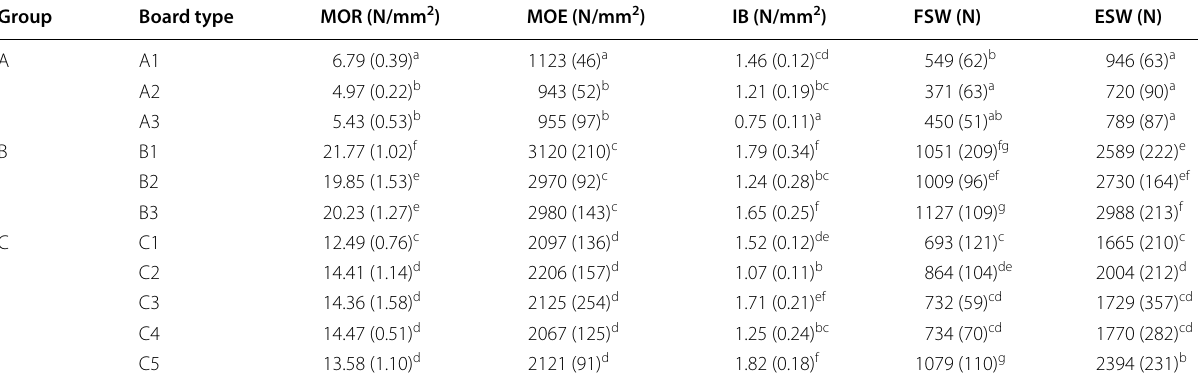
abcdefg Values with the same letters are not significantly different by Tukey HSD test ( P < 0.05)